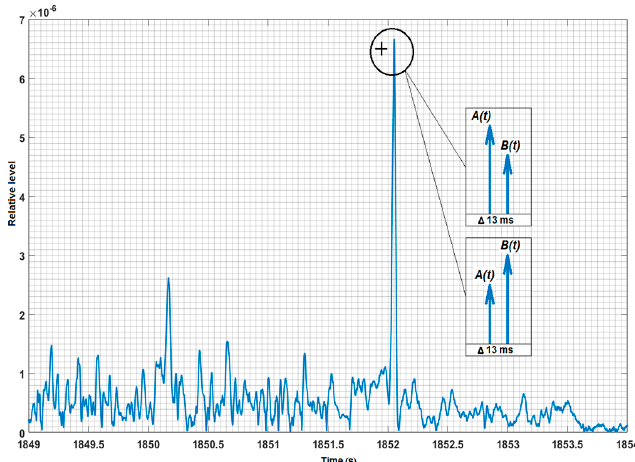
Figure 8. Responses of the matched filter on the M-sequences with length of 63 symbols.